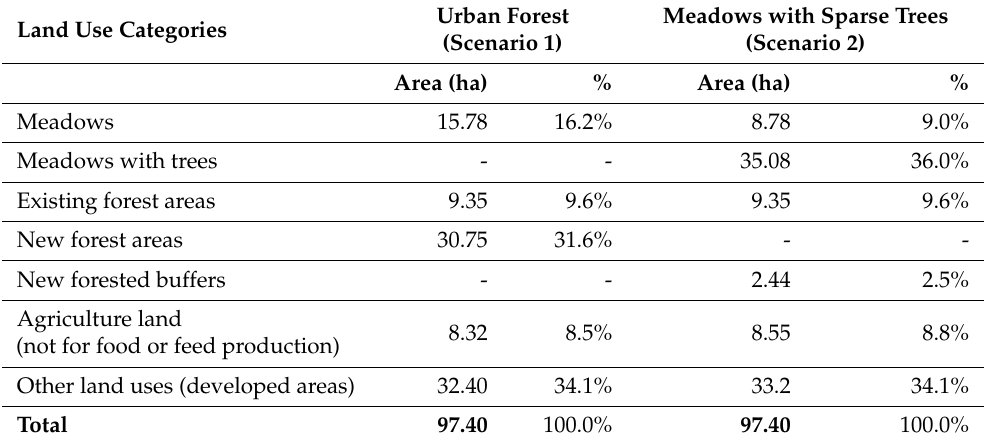
Table 1. Intervention scenarios and land use categories within